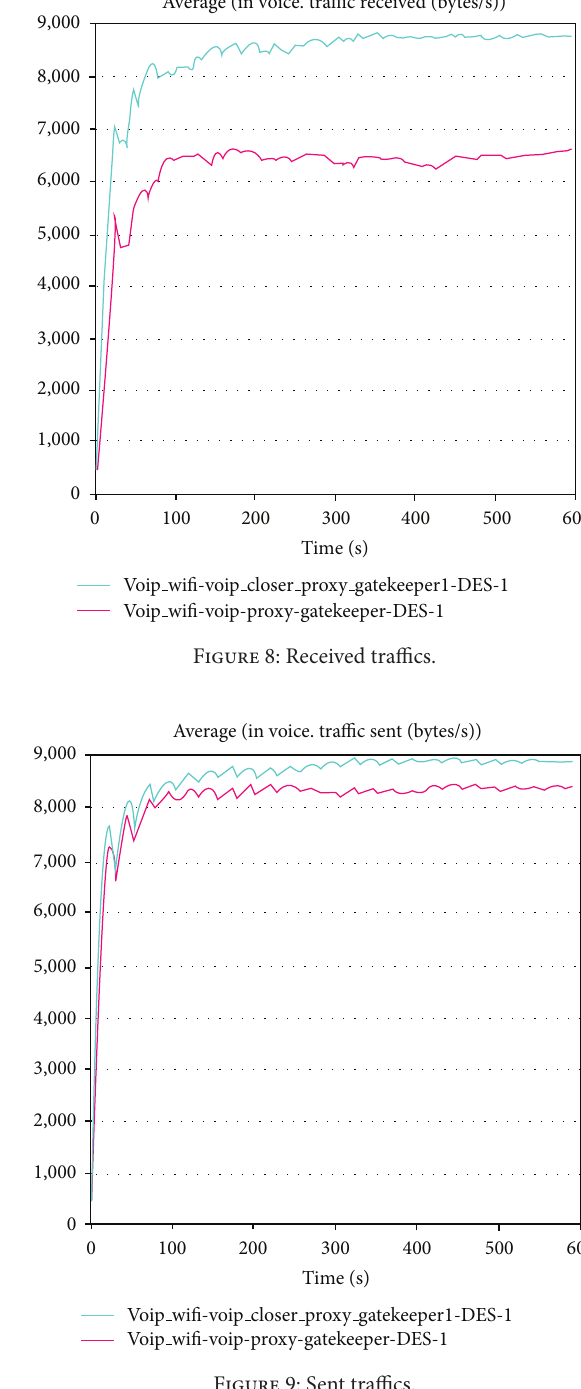
Figure 7: Packet end-to-end delay.